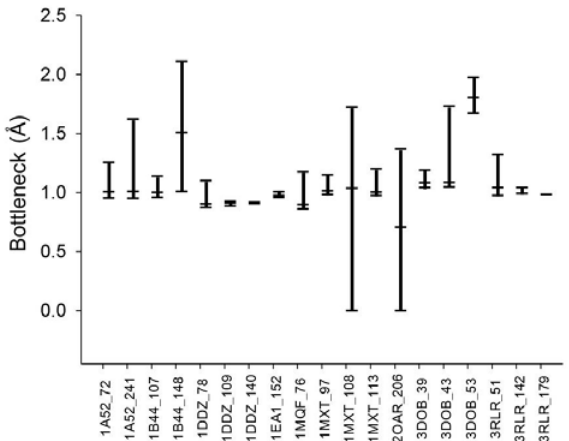
Figure 8. Dynamics of the tunnel bottleneck with valid rotamer conformations. The top and bottom bars indicate the maximum and minimum bottleneck sizes, respectively. The middle bar shows the average bottleneck size in the deformed tunnels.